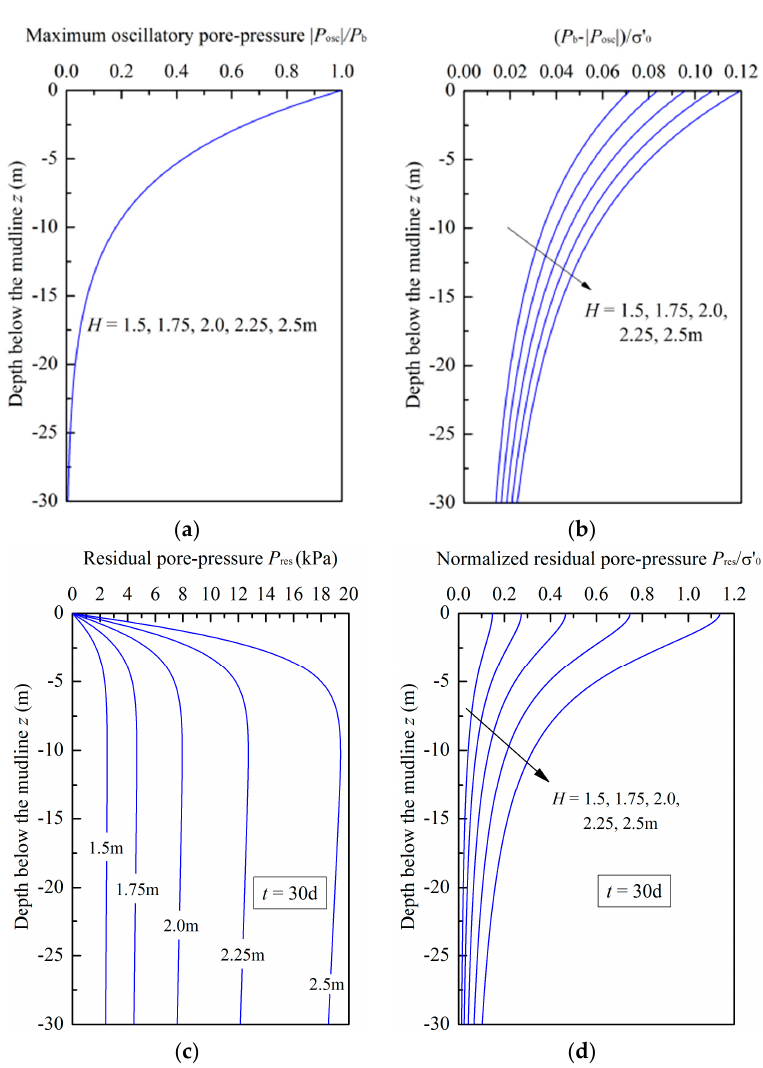
Figure 10. Distributions of the oscillatory pore-pressure and the residual pore-pressure for different wave heights: ( a ) Vertical distribution of | P osc | / P b for different H ; ( b ) vertical distribution of ( P − | P osc | ) / σ (cid:48) for different H ; ( c ) vertical distribution of P res for different H ; ( d ) vertical distribution of P res / σ (cid:48) for different H .